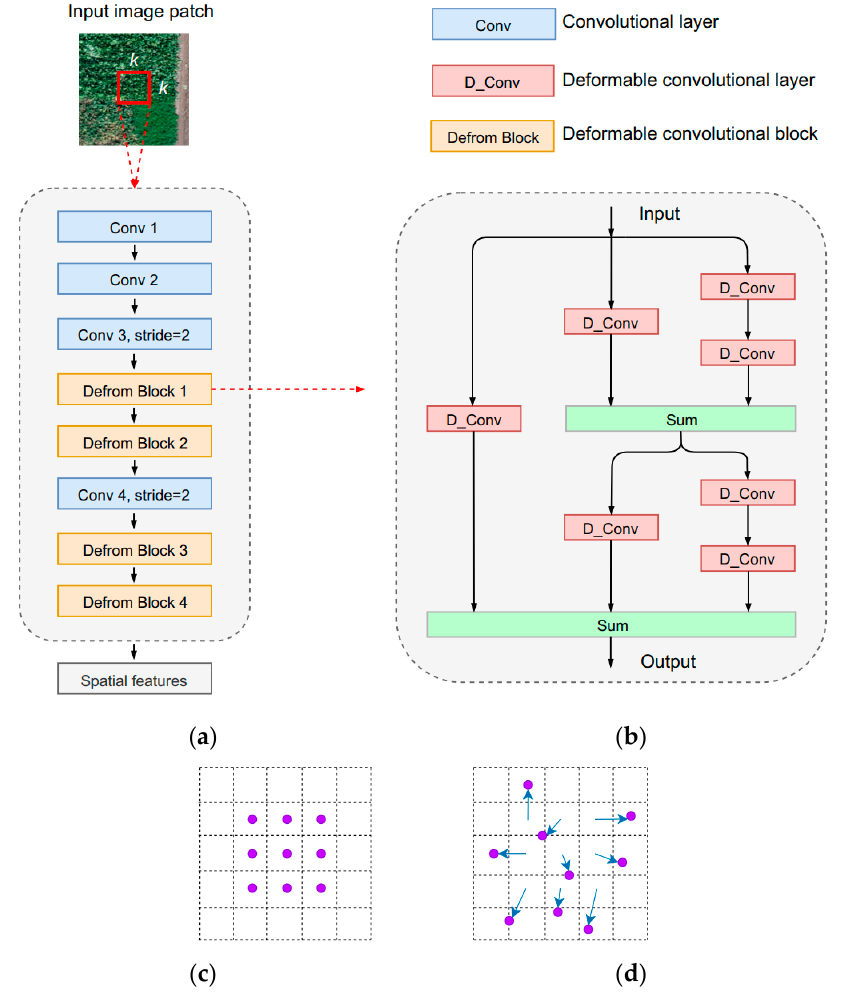
Figure 4. ( a ) Network structure of the proposed multi-scale deformable convolutional network (MDCN); ( b ) deformable convolutional block; ( c ) standard convolution; and ( d ) deformable convolution.